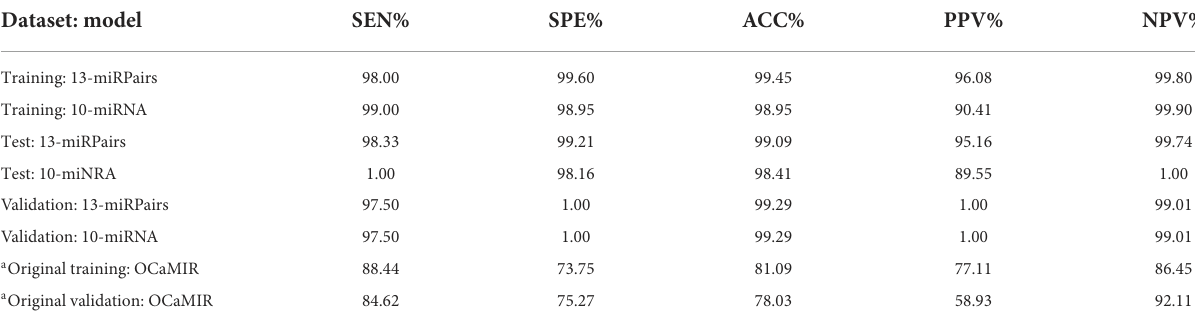
TABLE 3 Diagnostic performance of 13-miRPairs, 10-miRNAs, and OCaMIR.